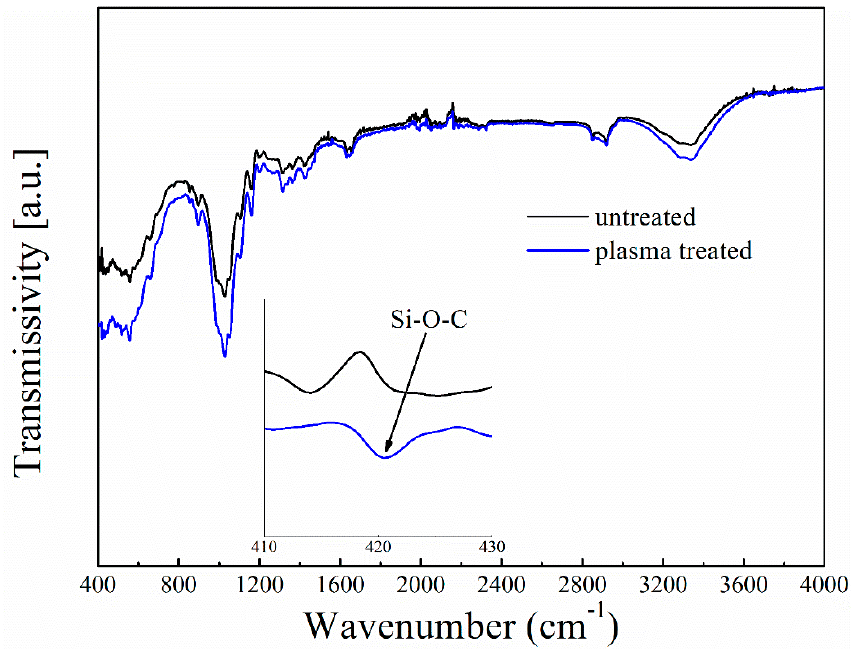
Figure 8. FTIR spectrum of the untreated and plasma-treated paper relics. The inset is the enlargement of the wavenumber region 410–430 cm − 1 .